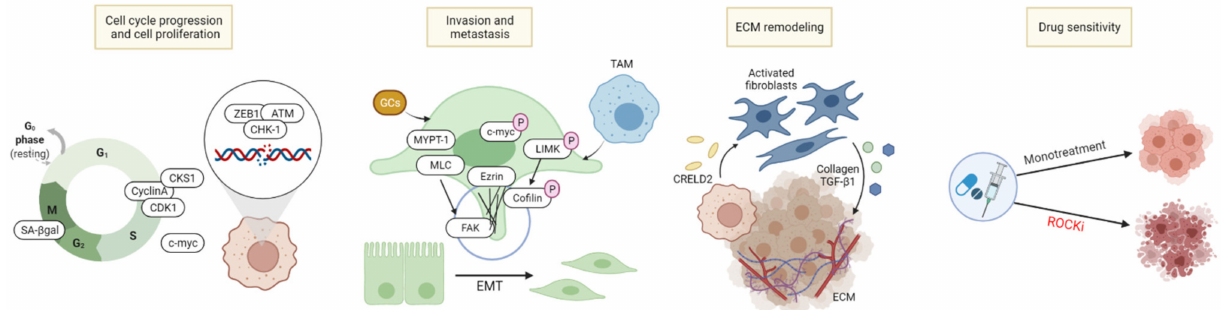
Figure 2. Cancer treatment strategies involving ROCK. ROCK is involved in multiple steps of the cell cycle and DNA damage response. ROCK further plays an important role in all stages of cancer cell metastasis including the formation of filopodia and lamellipodia, cytoskeletal reprogramming, EMT process, and the regulation of TME components. ROCK also activates pro-tumorigenic CAFs and increases the deposition of ECM components. This increase in ECM deposition promotes its stiffness and rigidity to exert tumor cell progression. Finally, ROCK inhibition combined with other chemotherapeutic agents can induce a synergistic antitumor